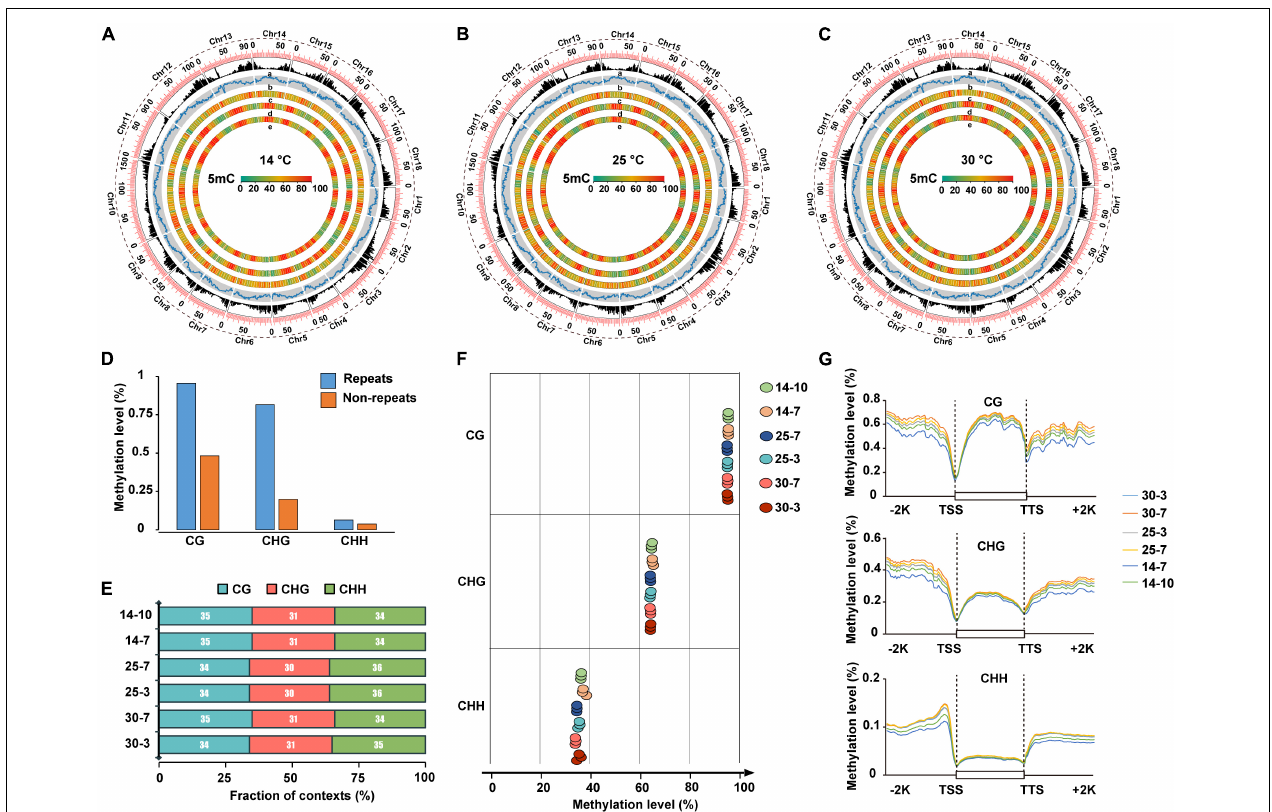
FIGURE 6 | Whole-genome DNA methylation profiling during M. micrantha seed development. Genome-wide profiles of CG, CHG, and CHH DNA methylation in circos across the chromosomes of the M. micrantha seeds germinated at 14 (A) , 25 (B) , and 30 ◦ C (C) . (a) Gene density; (b) TE density; (c–e) methylation levels of CG, CHG, and CHH sequences contexts, from outer to inner rings. (D) DNA methylation levels of the repetitive sequence regions and non-repeat regions in the M. micrantha genome. (E) Proportion of CG, CHG, and CHH contexts in the total number of methylation sites of the germs collected from three temperatures. (F) Weighted methylation levels of CG, CHG, and CHH contexts of M. micrantha seeds germinated at 14, 25, and 30 ◦ C. (G) Regional methylation levels in three sequence contexts of M. micrantha germs across gene-body and flanking regions in samples. A 2-kb region of the upstream or downstream regions, as well as the gene-body regions, was appropriately divided into 100 equal bins for the calculation of the mean methylation level. TSS, the transcription starts site of genes: the first base transcribed at the 50 end of the gene; TTS, the location where transcription ends at the 30 end of a gene sequence; Promoter: a 2-kb region of the TSS upstream; other region: regions expected for TSS, TTS, intron, exon, and